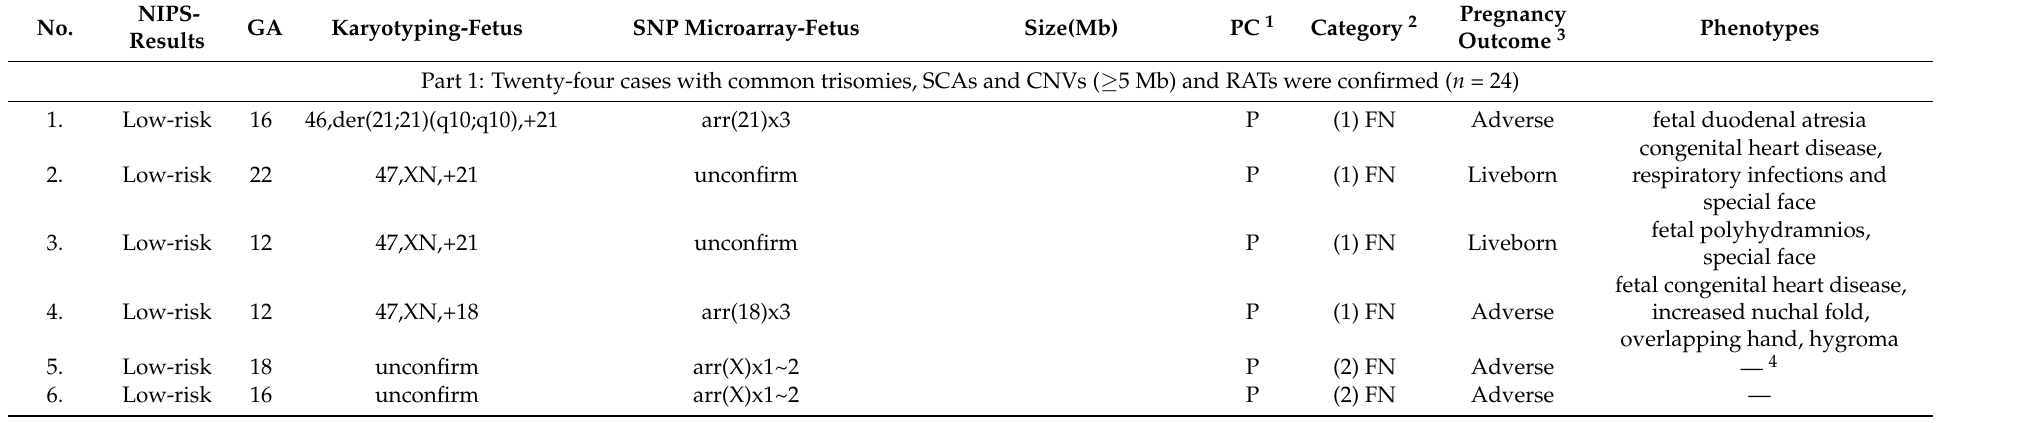
Table A3. Prenatal diagnosis for NIPS false negative cases and follow-up